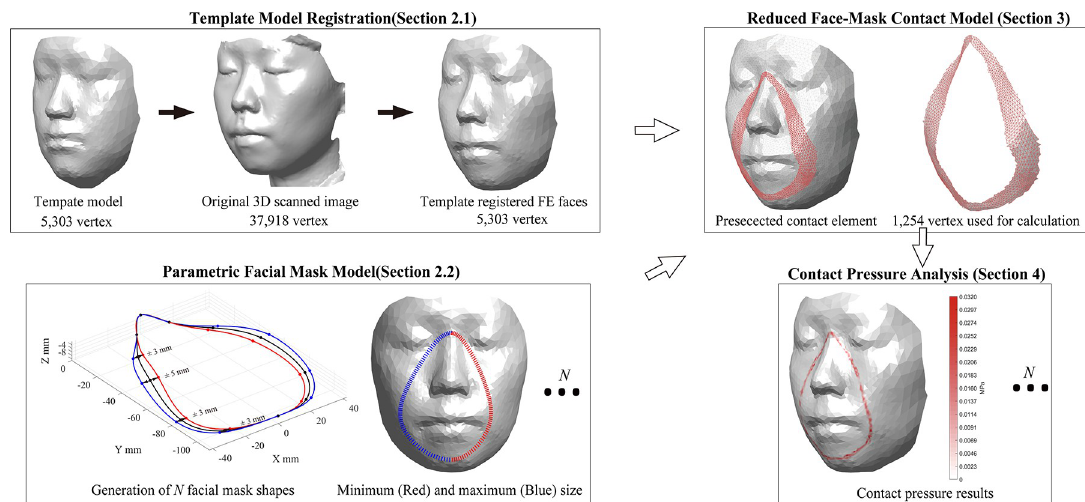
Fig 1. Concept of a novel design approach for a facial mask based on finite element analysis, illustrated with an example face image.